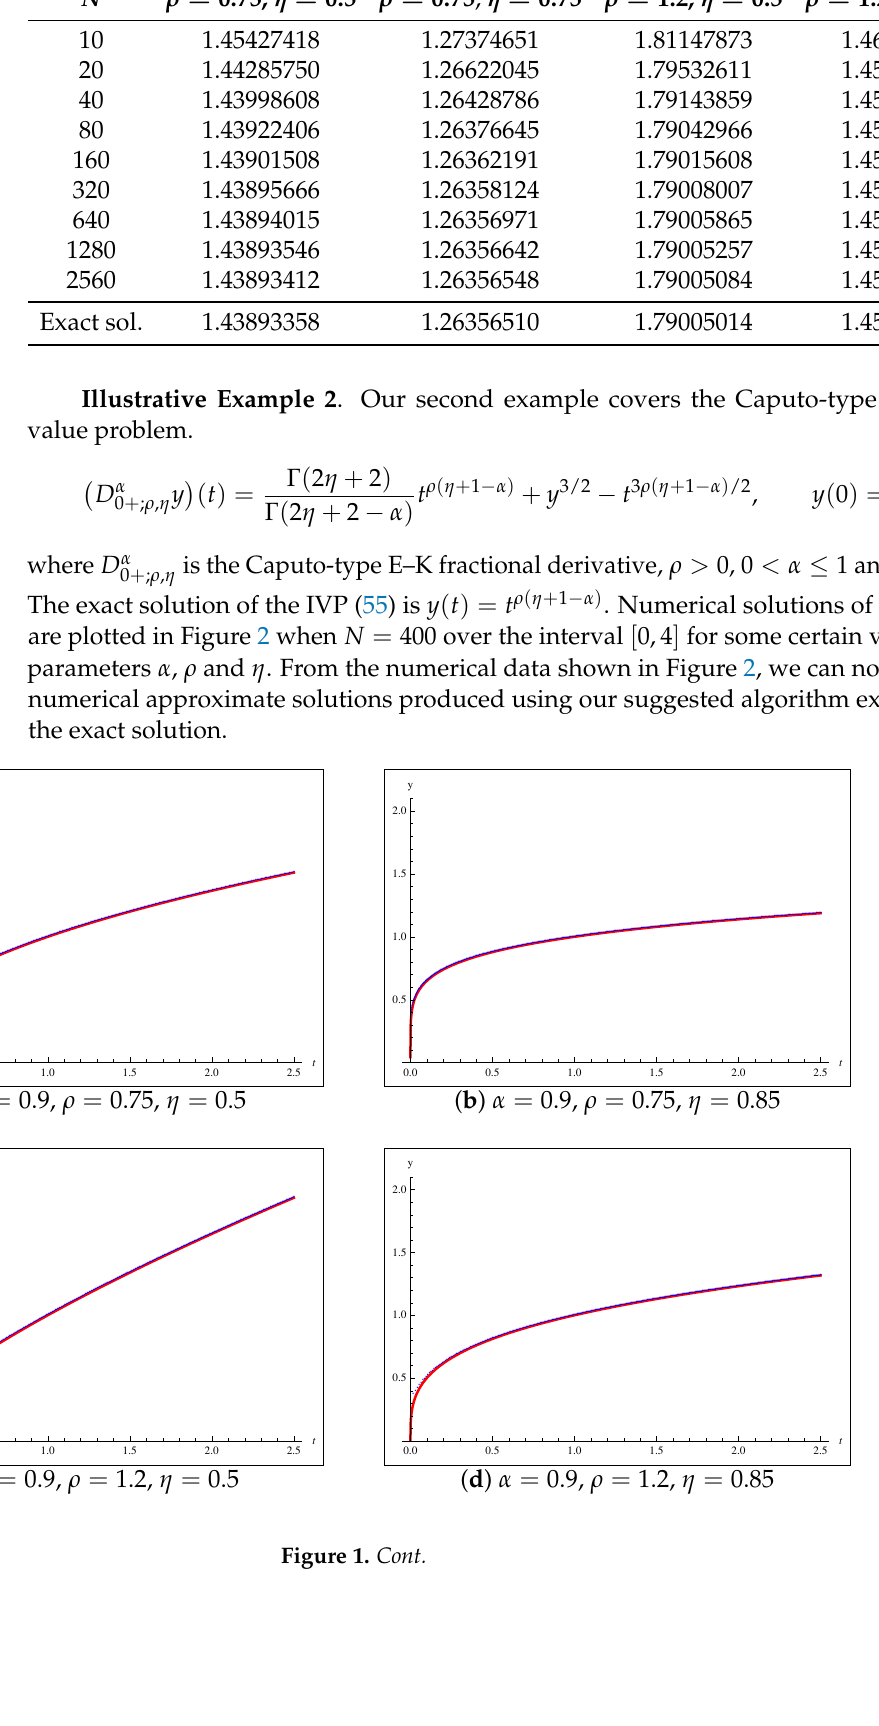
Table 2. Numerical solutions to the IVP (54) when α = 0.9 at t = 2. N